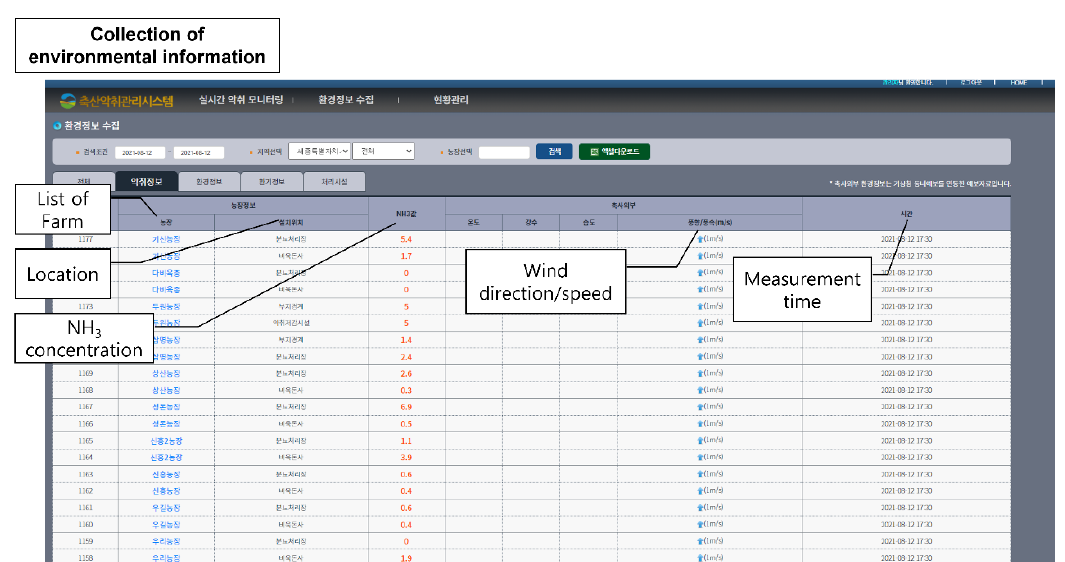
Figure 4. The web page collects environmental information in the livestock odor control system. The ammonia concentration and the environmental information for each branch can be checked.